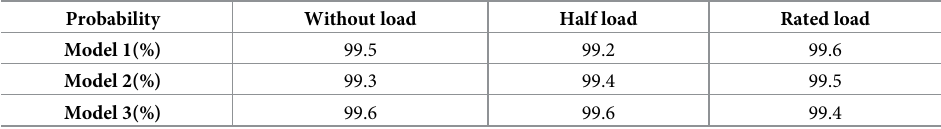
Table 3. Probability comparison of matching models under different loads.